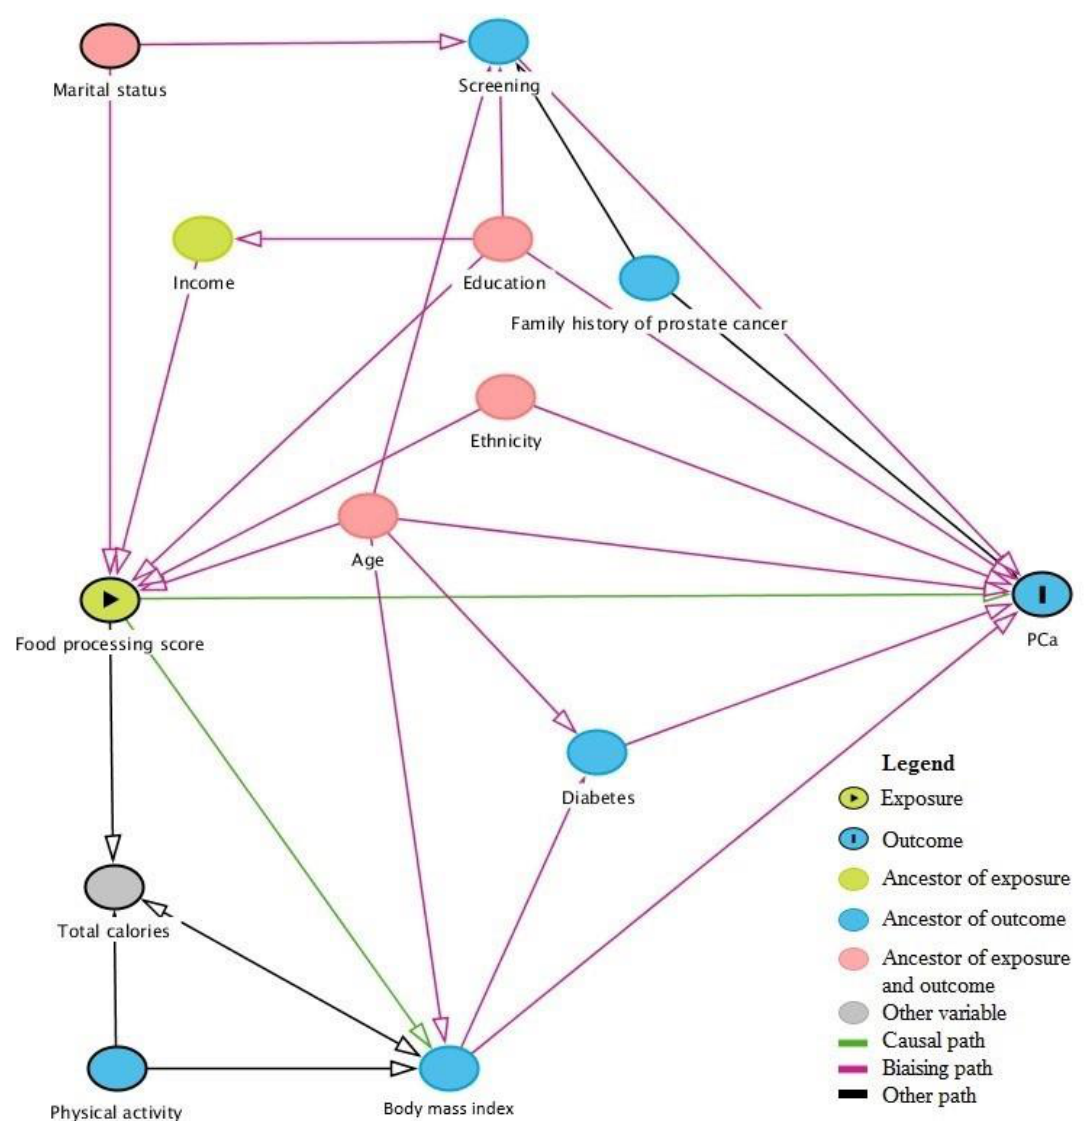
Figure 1. Directed acyclic graph (DAG) for the association between food processing and prostate cancer.